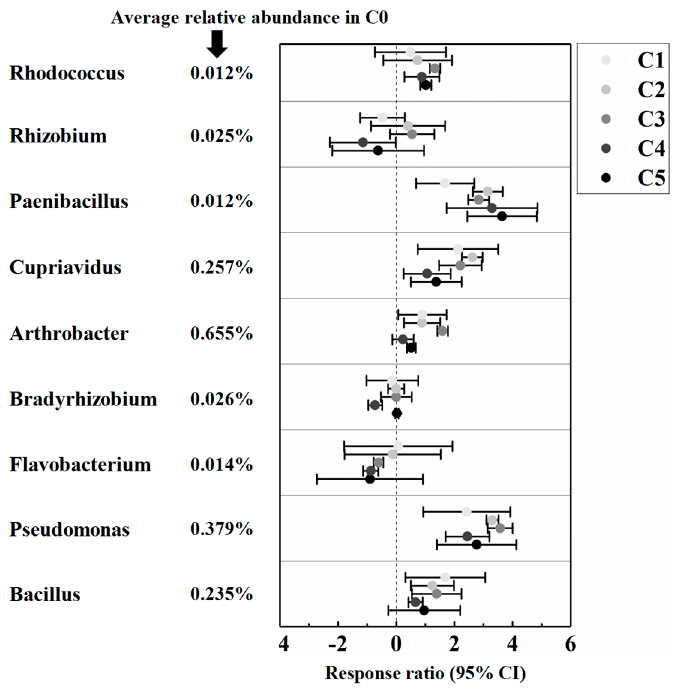
Figure 5. Response ratio analysis of changes in relative abundance of phosphate solubilizing bacterial OTUs in response to glucose addition compared to the C0 treatment, at 95% confidence interval. Error bar symbols plotted to the right of the dashed line indicate that the relative abundance increased, while those at the left side decreased.